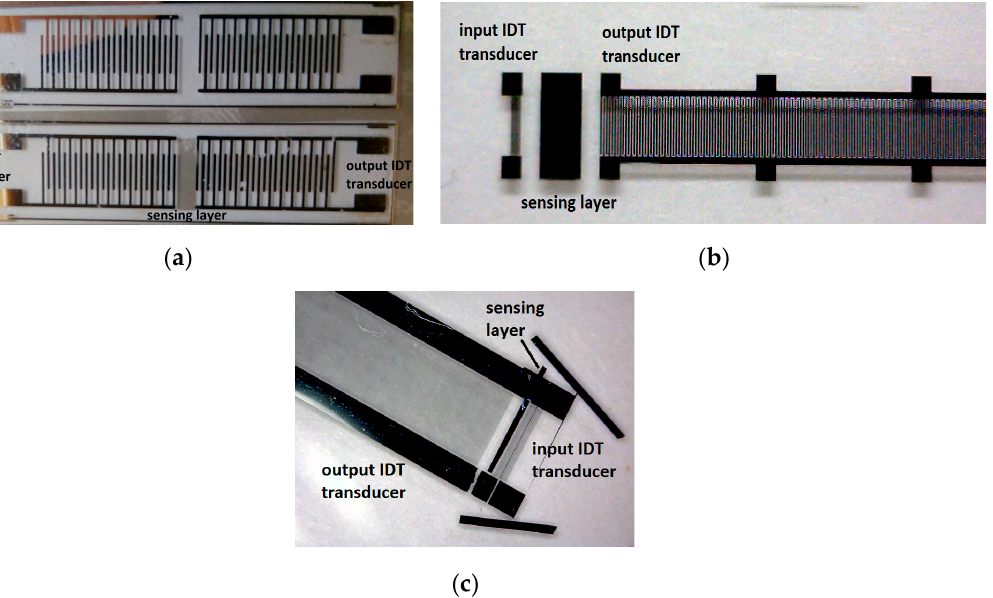
Figure 1. Photos and nomenclature of the prepared SAW structures: ( a ) device 1, ( b ) device 2, and ( c ) device 3. ( c ) device